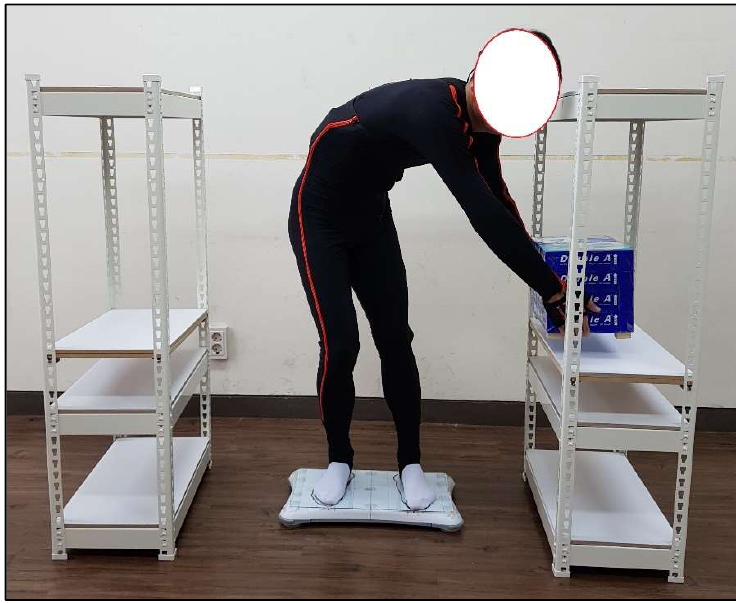
Figure 2. Schematic representation of the experimental tasks (take flat standing surface × 10 kg load carriage × Posture 5 as an example).